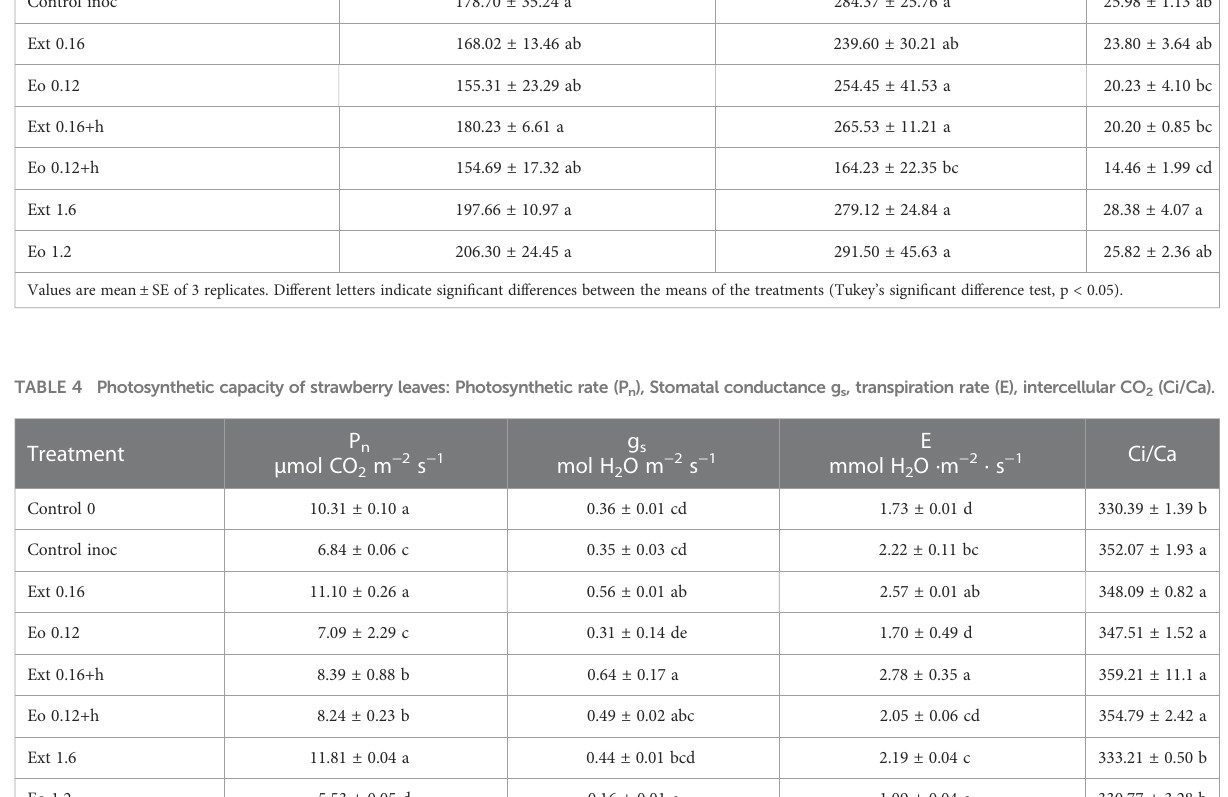
TABLE 3 Effect of coriander seed products applications on antioxidant system response of strawberry leaves.